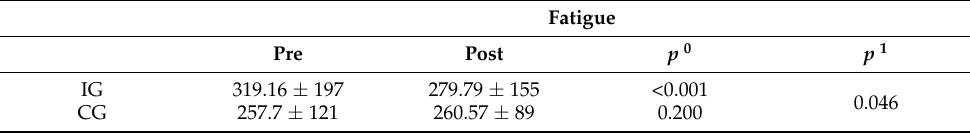
Table 2. Fatigue before and after the intervention. Data are reported as median ± interquartile range.